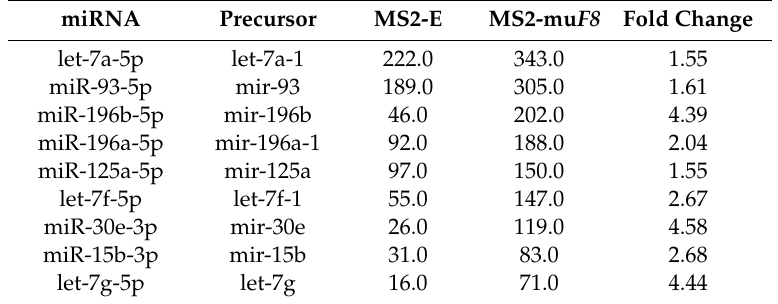
Table 1. Micro RNAs (MiRNAs) identified in MS2-tagged RNA a ffi nity assay. The list of 9 miRNAs detected in MS2-mu F8 3 (cid:48) UTR sample with the highest fold change compared to the control (MS2-E) with a fold change of read counts ≥ 1.5. The underlined miRNA was selected for further evaluation. miRNA Precursor MS2-E MS2-mu F8 Fold Change let-7a-5p let-7a-1 222.0 343.0 1.55 miR-93-5p mir-93 189.0 305.0 miR-196b-5p mir-196b 46.0 202.0 miR-196a-5p mir-196a-1 92.0 let-7f-5p let-7f-1